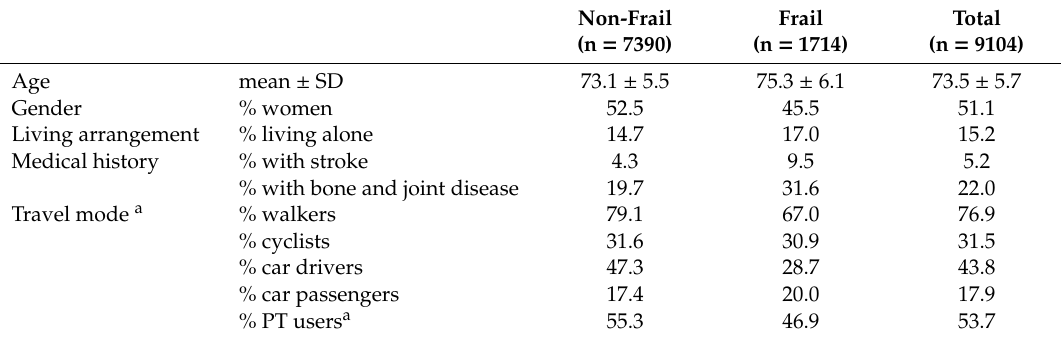
Table 1. Characteristics of participants by frailty